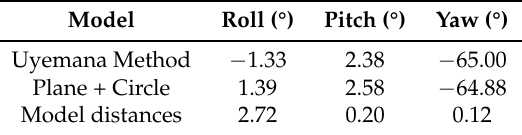
Table 3. Reference frame rotation